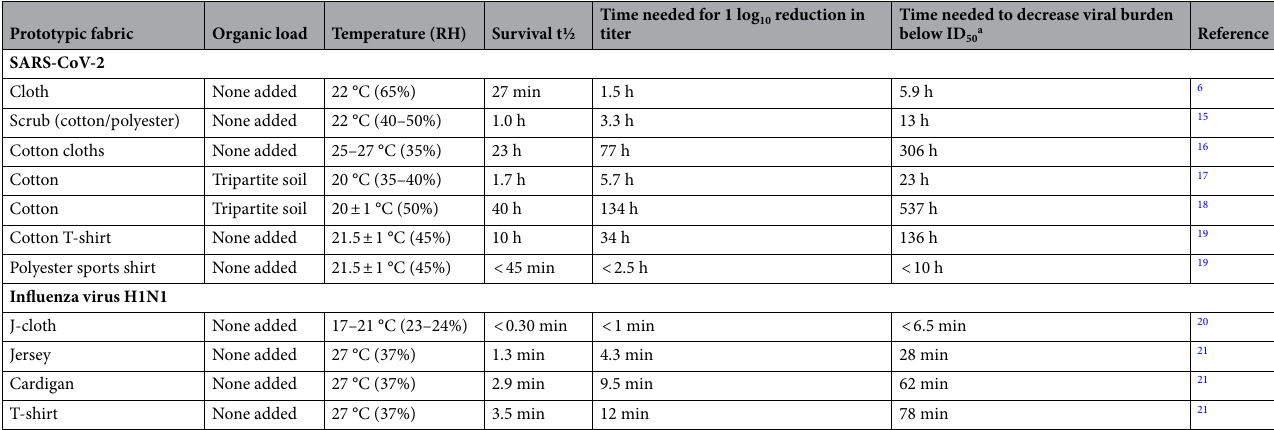
Table 4. Literature values for terminal survival half-life (t½) of SARS-CoV-2 and influenza virus H1N1 on clothing/fabrics.